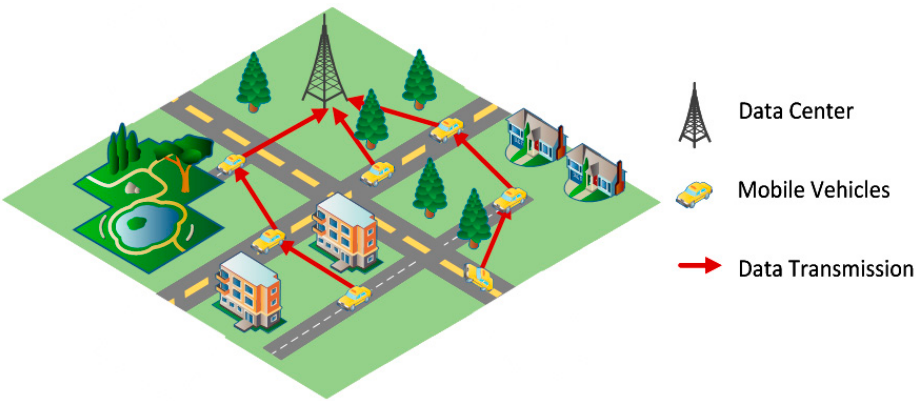
Figure 1. One application of the LCODC scheme